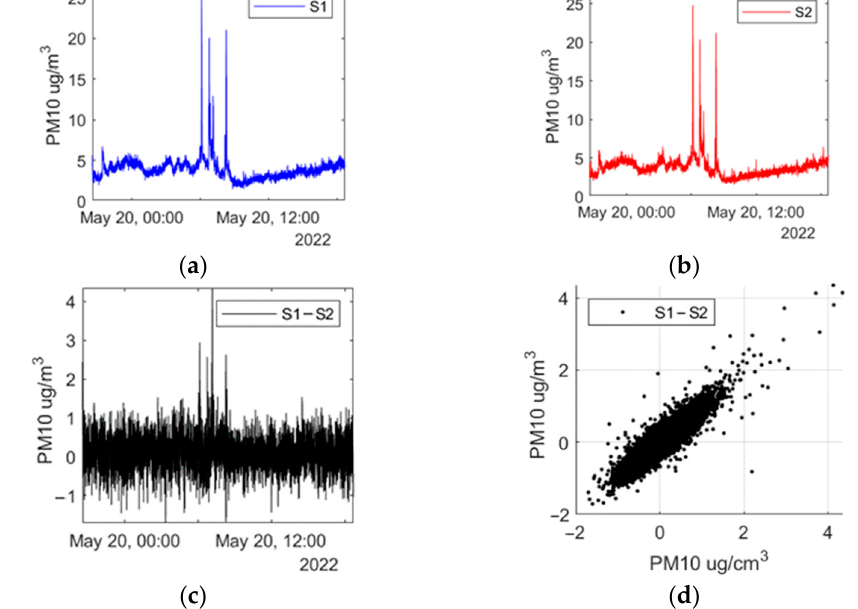
Figure 1. Comparative measurement between two SPS30 sensors: ( a ) Sensor 1 (S1); ( b ) Sensor 2 (S2); ( c ) Difference between Sensor 1 and Sensor 2 (S1–S2); ( d ) scatter plot of the difference between Sensor 1 and Sensor 2 (S1–S2).